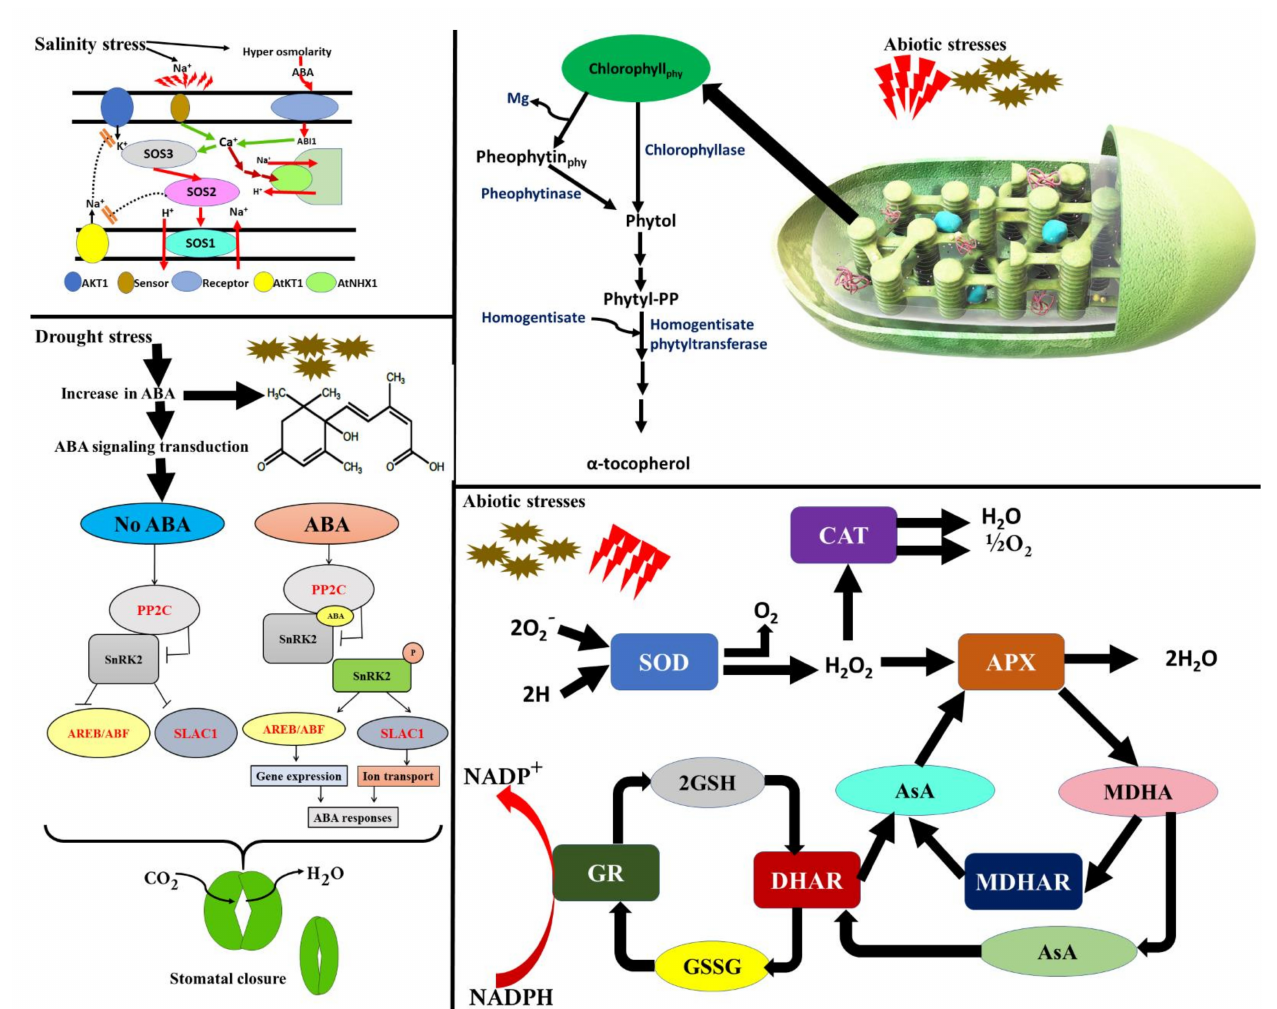
Figure 3. Schematic presentation of the underlying pathways that regulates the plant’s responses under a stressed